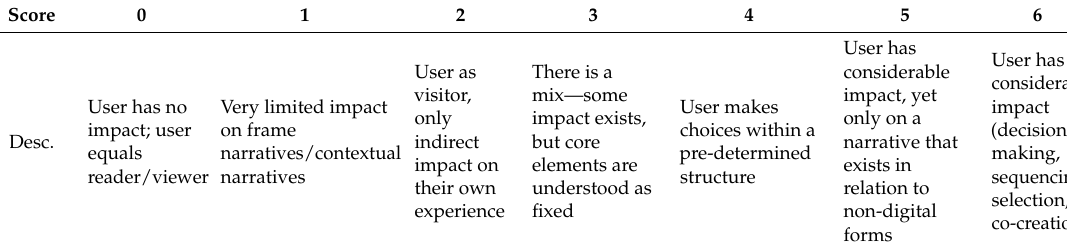
Table 2. Scale for user